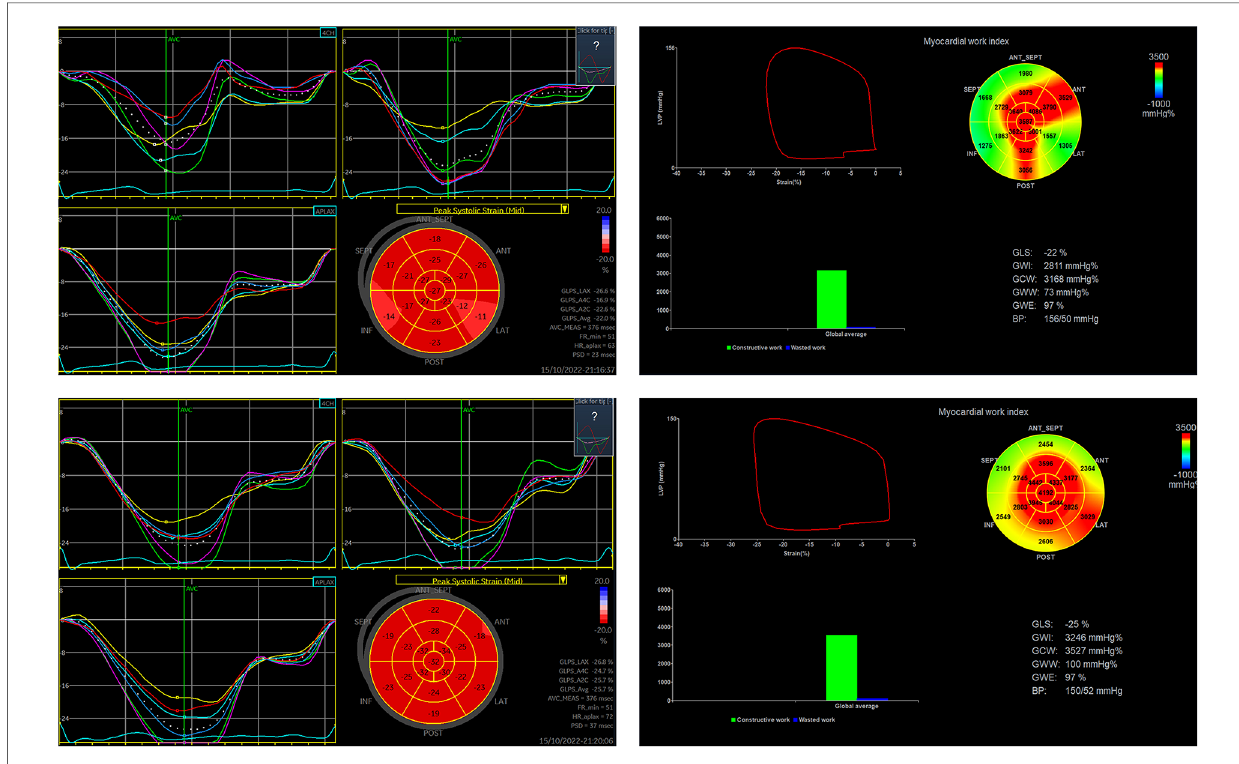
FIGURE 3 Changes in 2D-STE-related indexes and MW before and after adenosine stress in a patient in the CMD group. (The upper row shows 2D-STE related indices and MW at rest and the lower row shows 2D-STE related indices and MW at stress in ANOCA patient with CMD) (This patient was a 59-year- old woman, 1.66 m tall, 71 kg, with a blood pressure of 127/76 mmHg before and 102/64 mmHg after adenosine stress, who was treated with aspirin, statin and nicorandil before